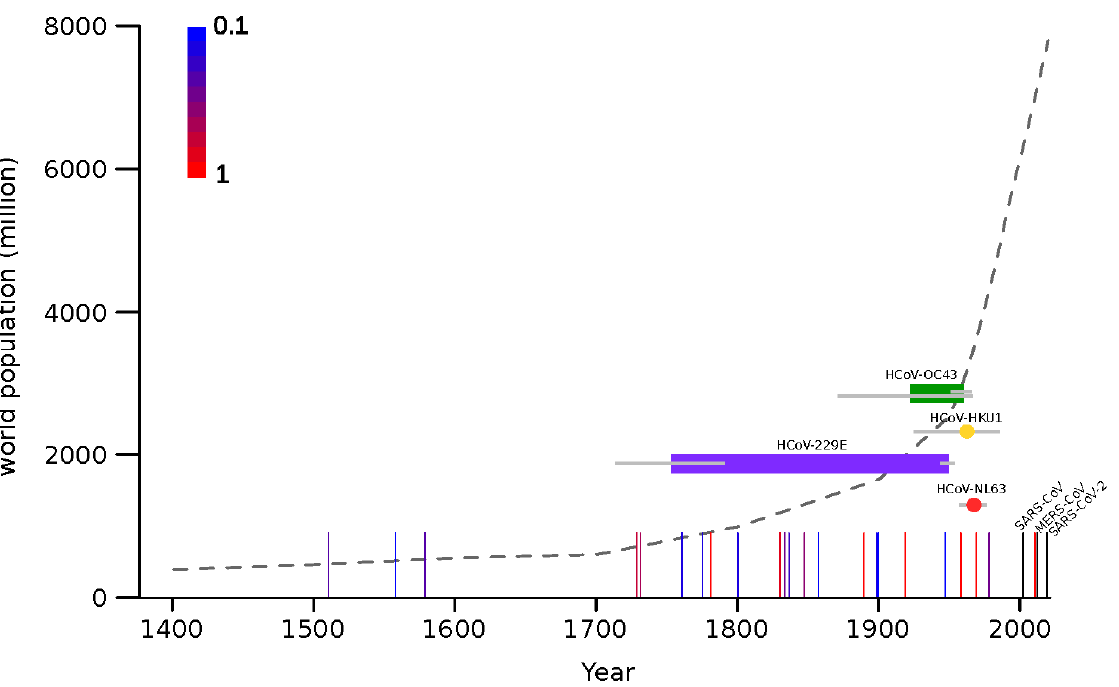
Figure 3. Timeline of endemic coronavirus emergence. Colored horizontal bars represent the time span between the divergence of each coronavirus from the closest known animal virus and the tMRCA (time to the most recent common ancestor) of circulating strains. In the case of HCoV-HKU1 and HCoV-NL63 tMRCA are shown as colored dots. Gray bars indicate 95% HPD. Vertical lines represent influenza pandemic events and the scaled colors (from blue to red, see legend on the plot) indicate the proportion of articles reporting that event as pandemic [33–42]. The three recent coronavirus zoonoses are shown as black vertical lines. The world human population count from 1400 C.E. is reported as a dotted gray line.